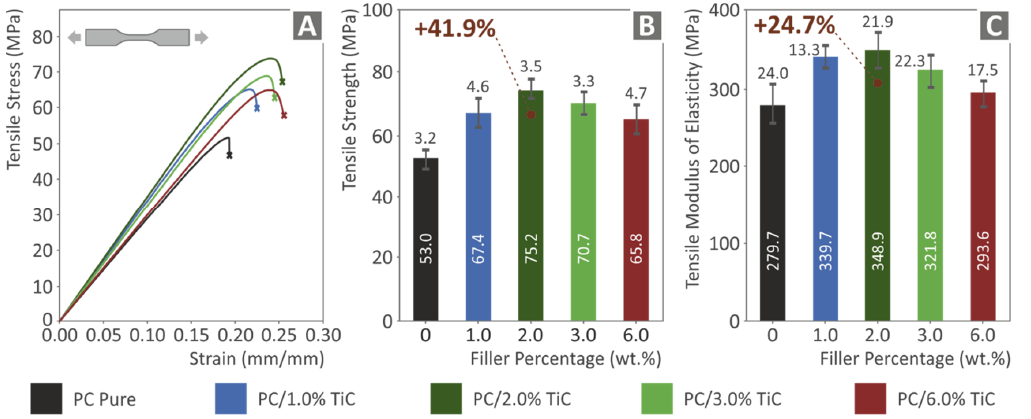
Figure 9. Tensile tests of all materials tested: ( A ) stress vs. strain graphs, ( B ) mean tensile strength and deviation, and ( C ) mean tensile modulus of elasticity and deviation.